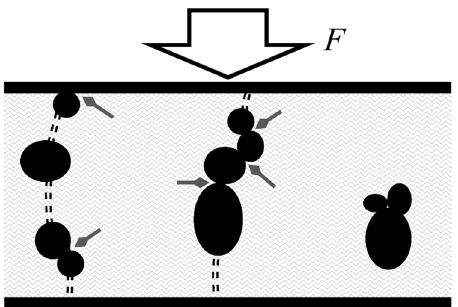
Figure 1. Sketch of a nanocomposite comprising randomly spaced conductive particles in an insu- lating polymer matrix; the material is sandwiched between metallic electrodes and subjected to an external compressive force ( F ). Quantum tunneling conduction is shown as double dashed line paths; they connect isolated particles, thus creating the tunneling resistance. Greyed diamond arrows mark the constriction resistance occurring between adjacent particles (as well as between electrode and particles in contact); they create the constriction resistance ( R c ). Particles located too far from each other fail to create a conduction path.